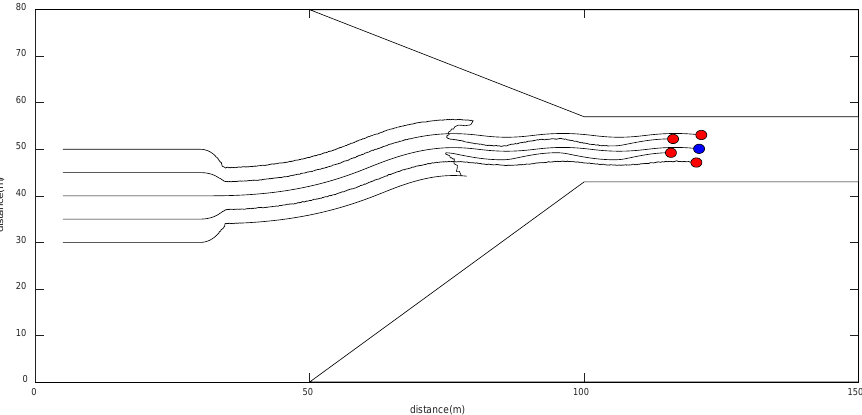
Figure 20. Trajectory of the UGVs fleet in the case of road narrowing ahead.